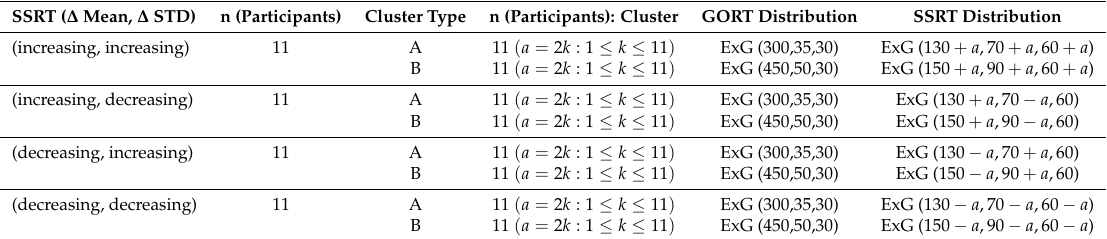
Table 1. Structure of simulated stop task data by participant sample size (SST data sample size per participant: N =